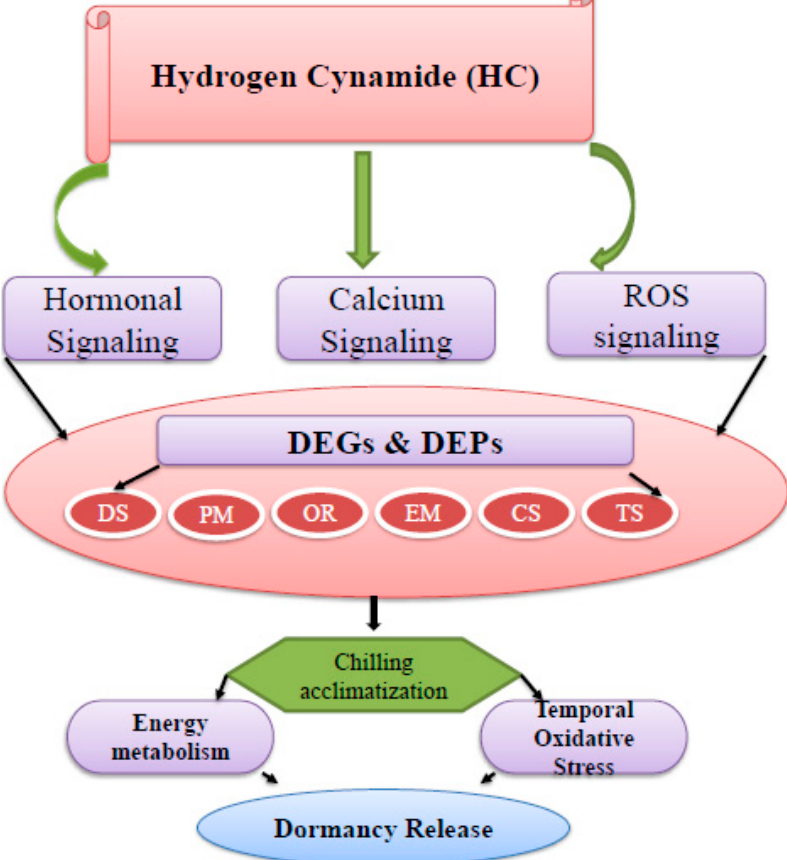
Figure 6. Proposed molecular model of bud dormancy release in grapes after HC application. In this model after HC application, hormone signaling, ROS signaling and Ca +2 signaling control the expression patterns of different type of genes and proteins including DS (defense and stress) PM (protein metabolism), OR (oxidation-reduction), EM (energy metabolism), CS (cell structure) and TS (transcription and signaling).